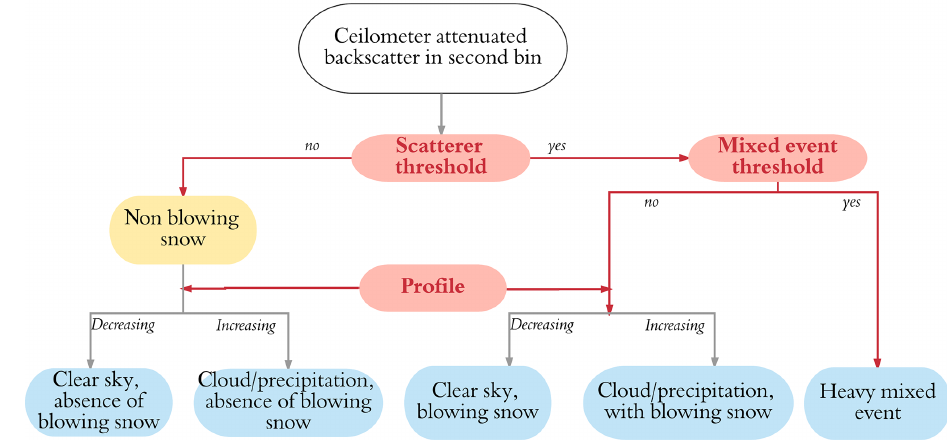
Figure 5. Chart of the blowing snow detection method.